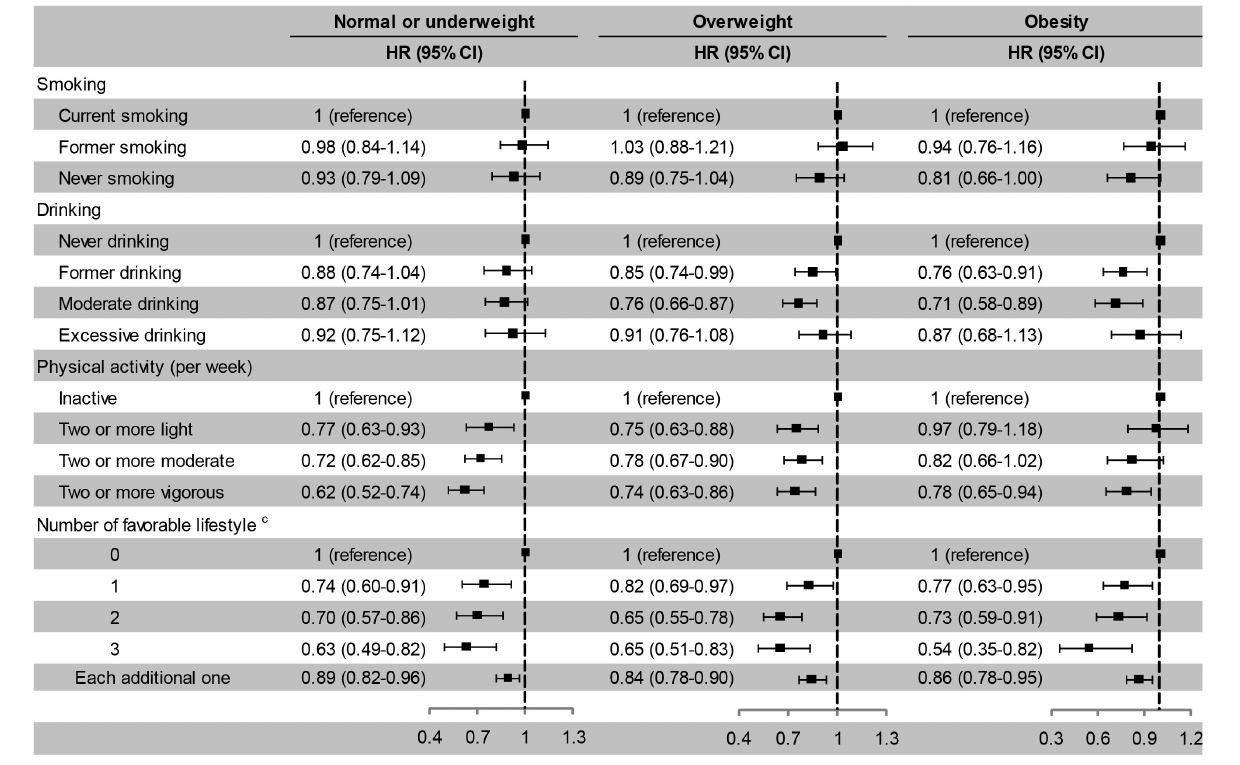
FIGURE 5 | Risk of cognitive impairment according to lifestyle stratified by body weight status. The model adjusted for smoking, drinking, physical activity, baseline age, sex, education, marriage, family wealth per capita, and PRS for BMI. c Moderate drinking was considered favourable. HR, hazard ratio; CI, confidence interval. The significance level was set at α =